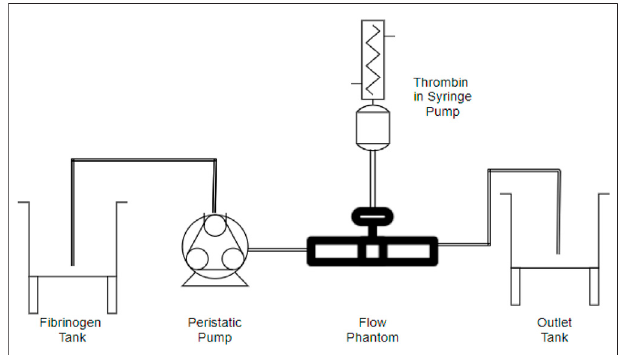
FIGURE 2 | Illustration of experimental